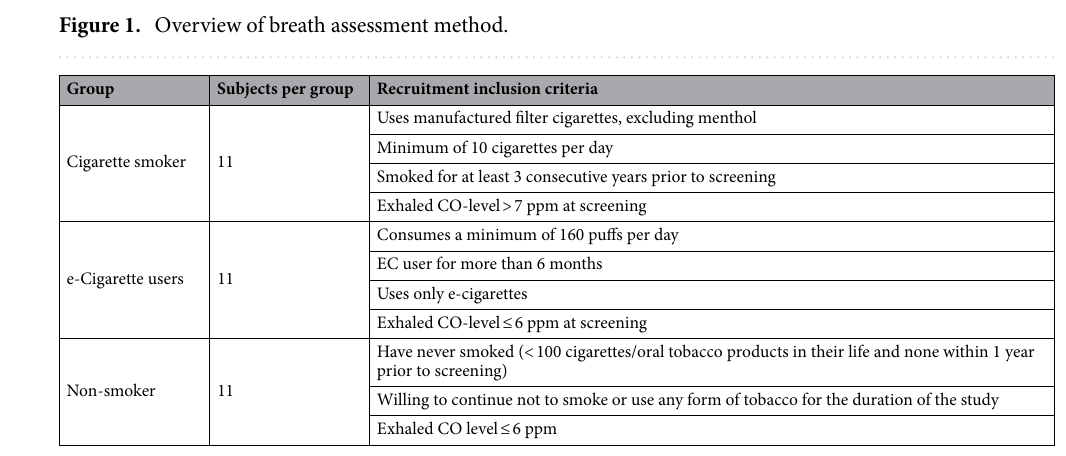
Table 2. Subjects recruited for breath